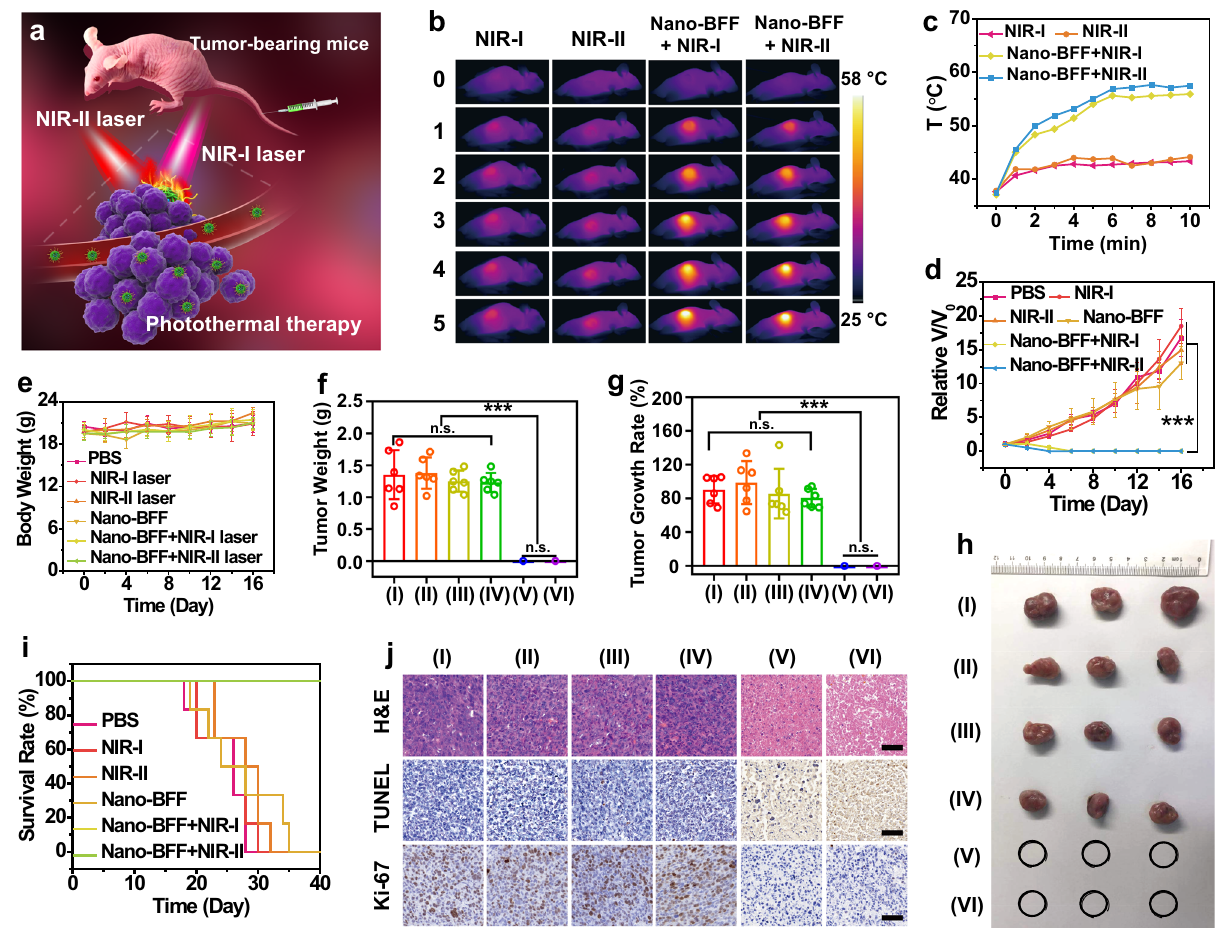
Fig. 5 In vivo photonic tumor hyperthermia based on Nano-BFF in both NIR-I and NIR-II biowindow. a Scheme of photonic cancer hyperthermia induced by Nano-BFF. b IR thermal images, and c tumor temperature variations of the mice in different treatment groups (NIR-I laser, NIR-II laser, Nano-BFF + NIR-I laser, and Nano-BFF + NIR-II laser) ( n = 6 biologically independent samples). d Relative tumor volumes, e body weight variations of the mice, f tumor weights, and g tumor growth rates of 4T1 tumor-bearing mice after various treatments ( n = 6 biologically independent samples). h Representative photographs of dissected tumors and i survival rates of the mice bearing 4T1 tumors after different treatment. Data are presented as mean values ± SD. n.s.: not signi fi cant. p > 0.05; * p < 0.05; ** p < 0.01; *** p < 0.001, analyzed by Student ’ s two-sided test. j H&E, TUNEL, and Ki-67 immuno fl uorescence staining of the tumor tissues after various treatments (I: PBS; II: NIR-I laser; III: NIR-II laser; IV: Nano-BFF; V: Nano-BFF + NIR-I laser; VI: Nano-BFF + NIR-II laser). Scale bars: 50 μ m. A representative image of three biological replicates from each group is shown. NATURE COMMUNICATIONS| (2021) 12:218